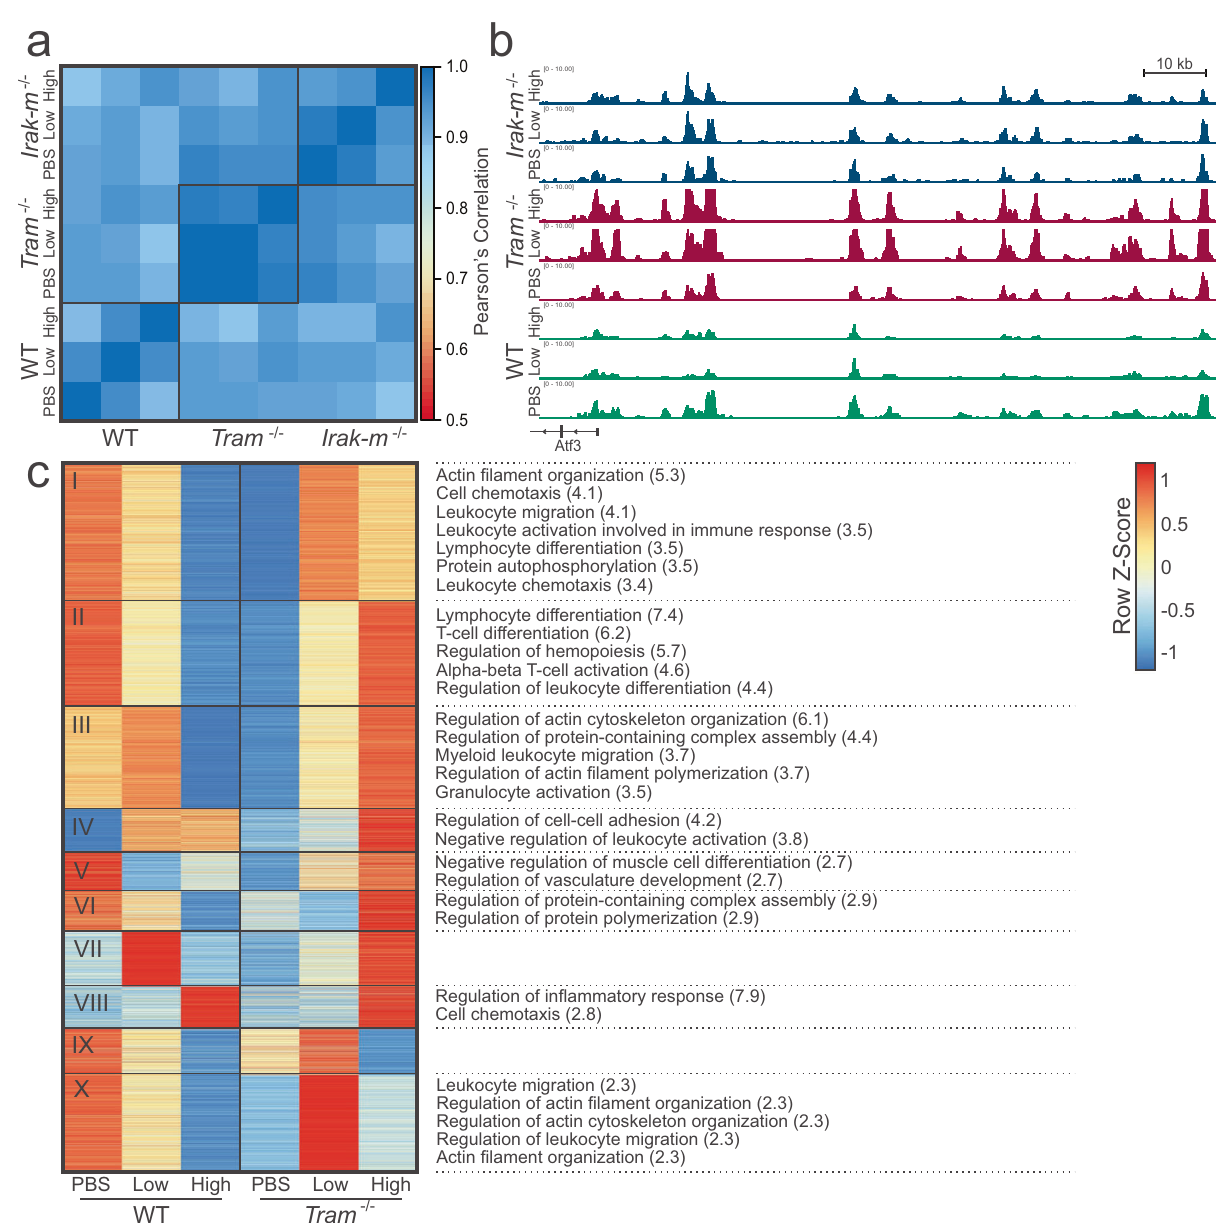
Fig. 4 Effect of LPS on H3K27ac in TRAM-de fi cient and IRAK-M-de fi cient cells. a Pearson ’ s correlation of normalized H3K27ac signal at promoter regions (TSS ± 2 kb) of WT, Tram − / − , and Irak-m − / − . b Representative tracks of normalized H3K27ac signal from WT, Tram − / − , and Irak-m − / − . Tracks are aligned in mm10 and the region displayed is chr1:191,173,497-191,334,210. c Normalized H3K27ac signal at WT enhancers in WT and TRAM-de fi cient cells. Signi fi cant biological process gene ontologies (FDR < 0.05) listed on the right, with log(FDR) in